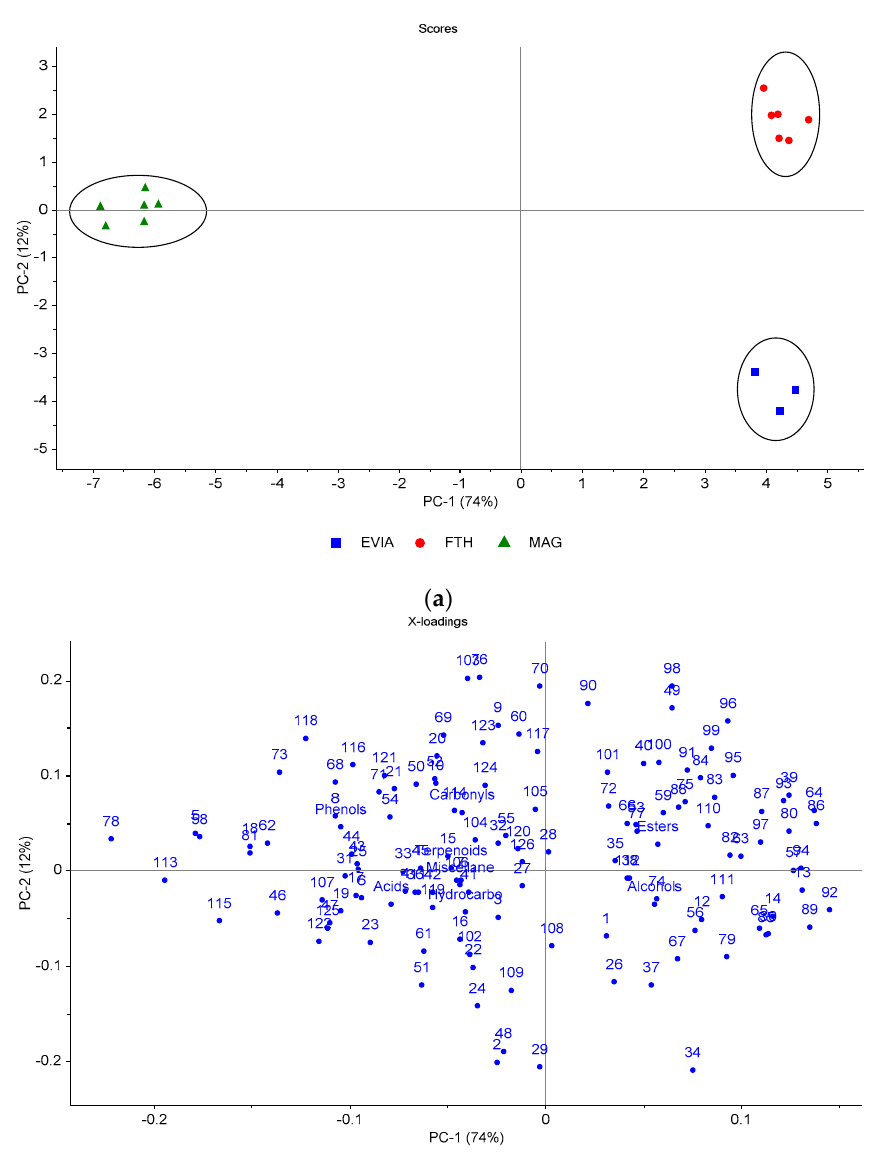
Figure 3. Principal component analysis of the volatile compounds identified in cv. Conservolea natural black olives grown in northern Evia (EVIA), Fthiotida (FTH) and Magnesia (MAG): ( a ) scores plot, ( b ) loadings plot of the first two principal components. The codes of variables are given in Table 2.